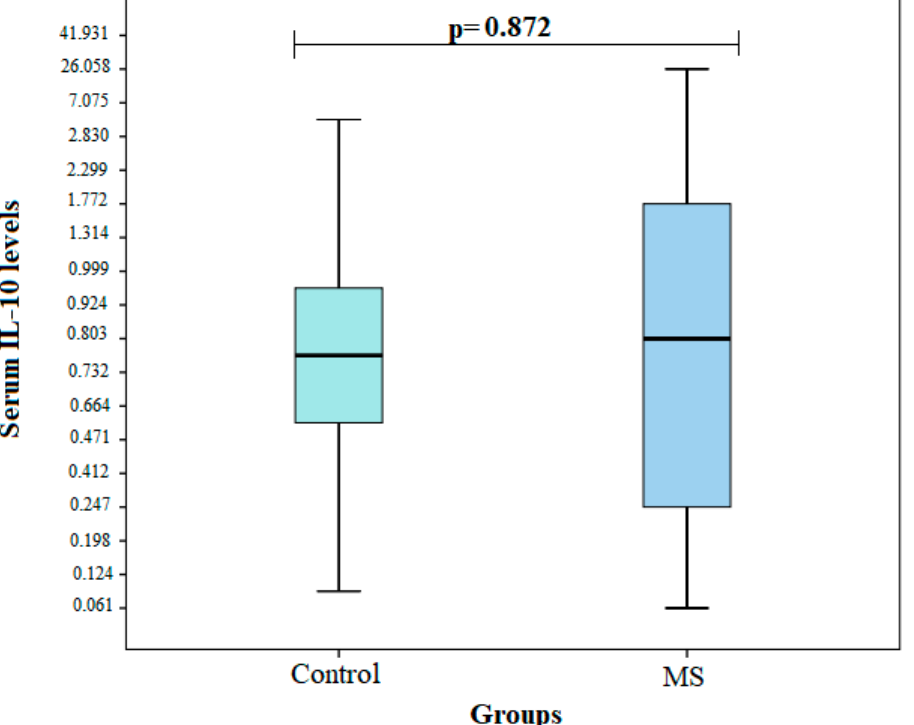
Serum IL-10 levels were measured in groups of patients with MS ( n = 26) and healthy subjects ( n = 19). Comparing the IL-10 serum levels between the two groups, no statistically significant differences were observed (median IQR): 0.828 (1.533) vs. 0.756 (0.528), p = 0.872)